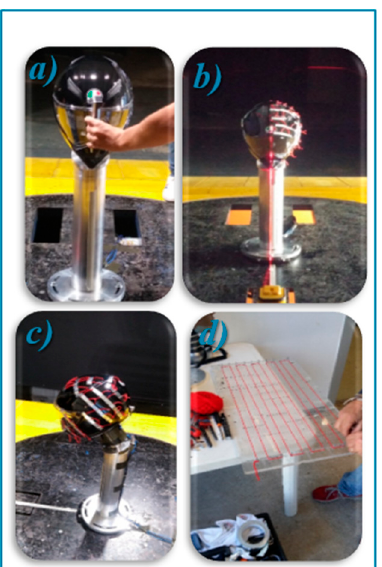
Figure 3. Alignment of the helmet with respect to the wind current.